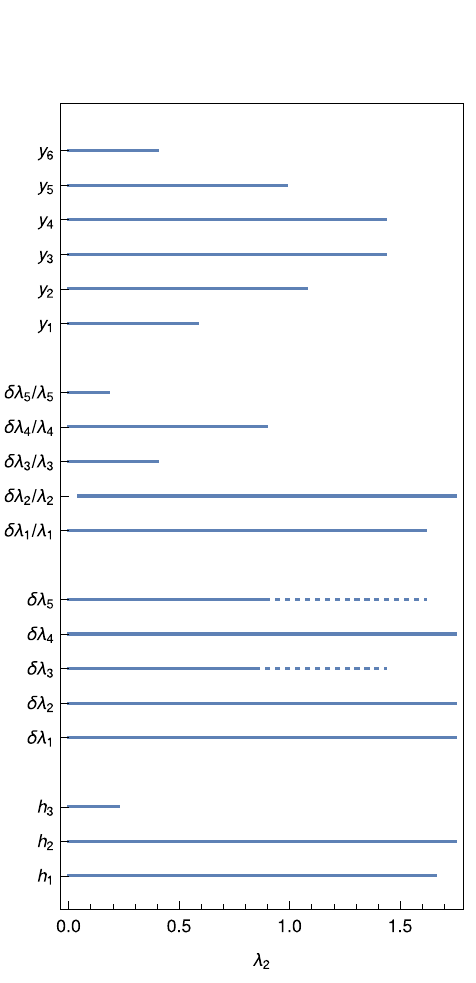
(b) Comparison of the different perturbativity limits. See Fig. 4 for more details.